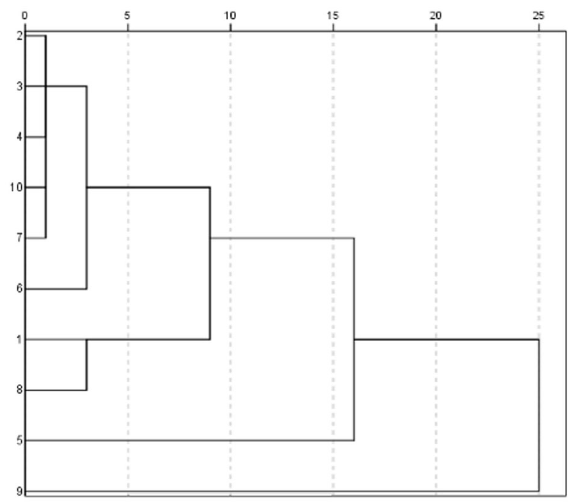
Figure 1: Cluster analysis of Cistanche from ten diverse habitats, which were grouped into three clusters: (A) 2, Guizhou; 3, Qinghai; 4,Chaidamu; 10, Neimeng; 7, Xinjiang; and 6, Sichuan. (B) 1, Xizang; 8, Ningxia; and 5, Alashan. (C) 9,